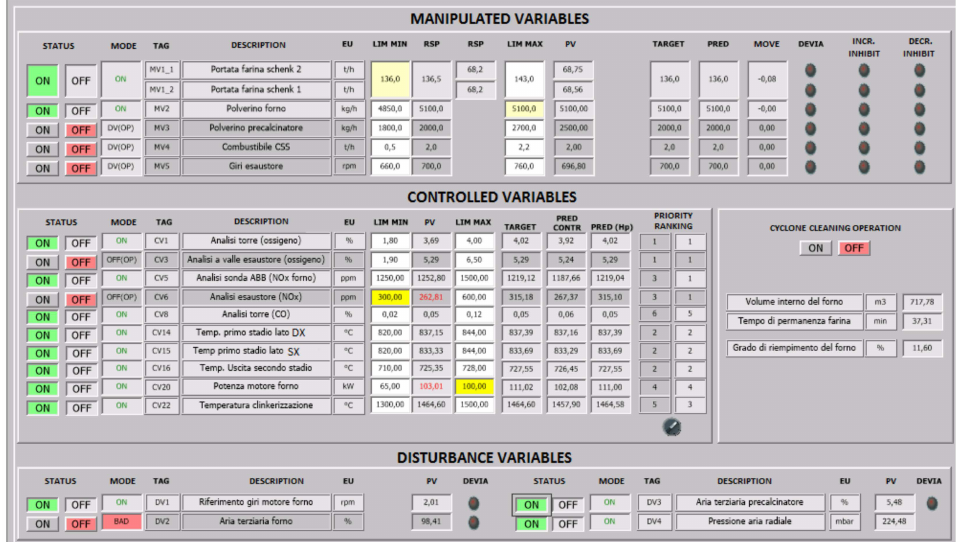
Figure 6. Rotary kiln APC system: example of an APC system GUI synoptic (MVs, main CVs and